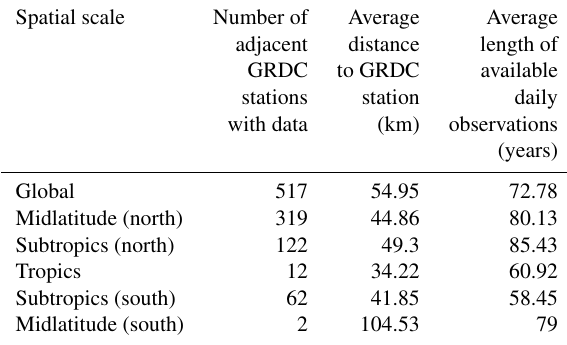
Table B1. Summary of GRDC stations ( < 110km) with available daily observations (at least) from 1985 to 2015 adjacent to the cor- responding reported DFO flood